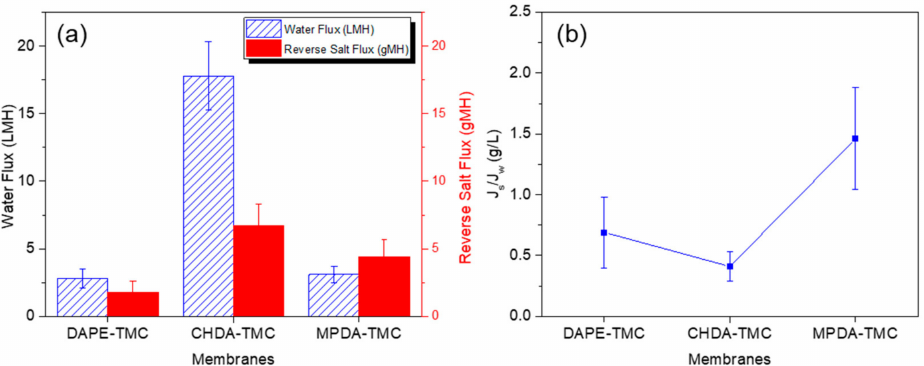
Figure 8. Comparison of ( a ) water flux and ( b ) reverse salt flux for various composite polyamide